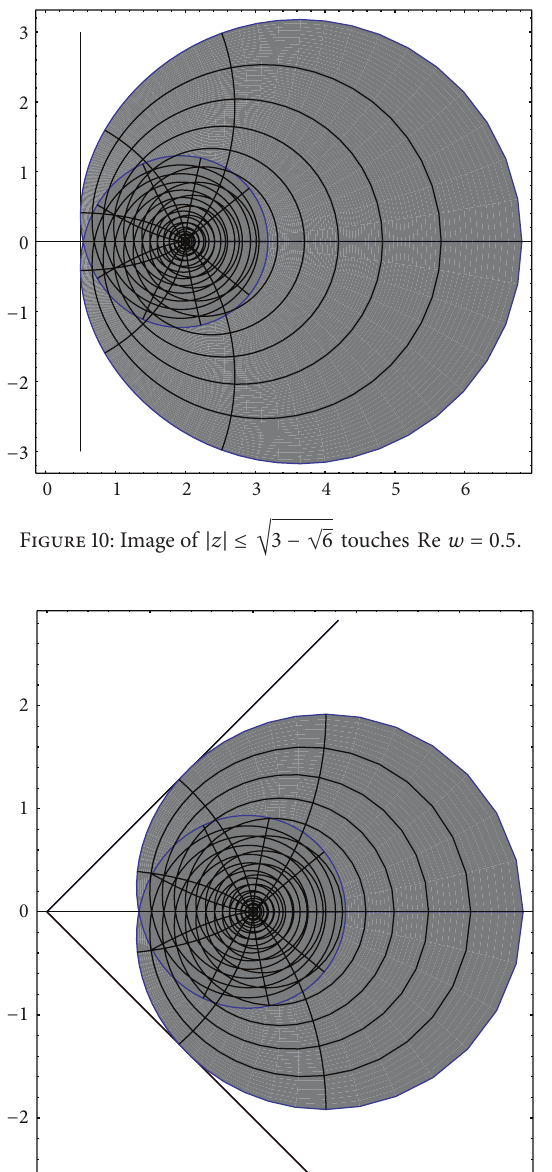
Figure 11: Image of |𝑧| ≤ 0.6335 touches | arg 𝑤| = 𝜋/4 .